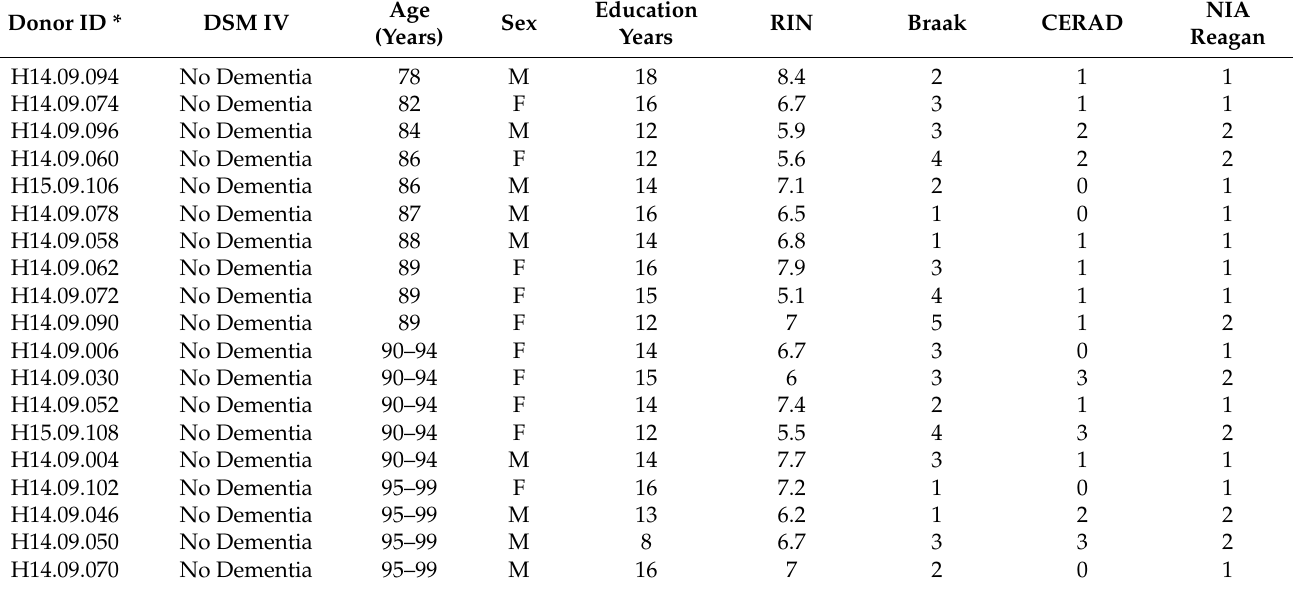
Table 2. Summary of donor